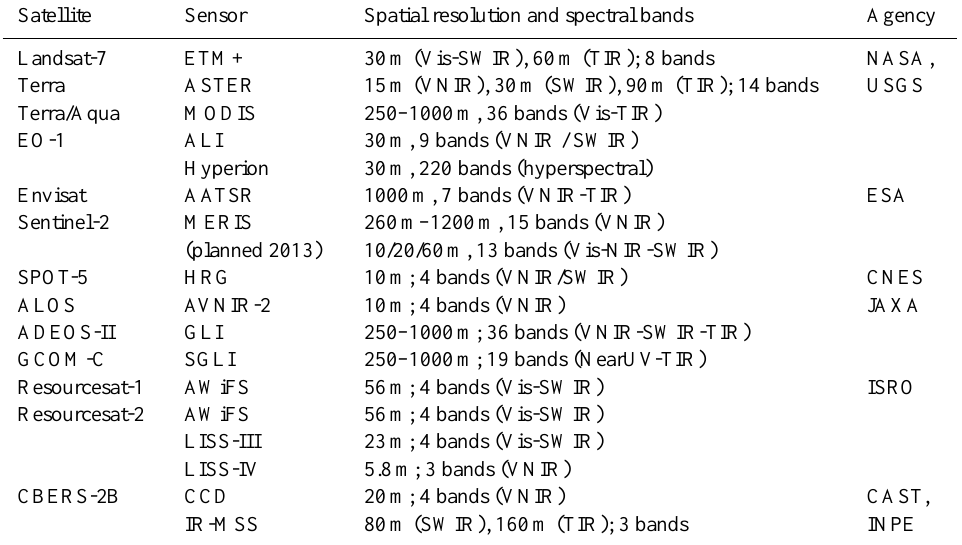
Table 1. The major currently operating optical imaging earth observation satellite instruments suitable for snow cover study. Satellite Sensor Spatial resolution and spectral bands Agency